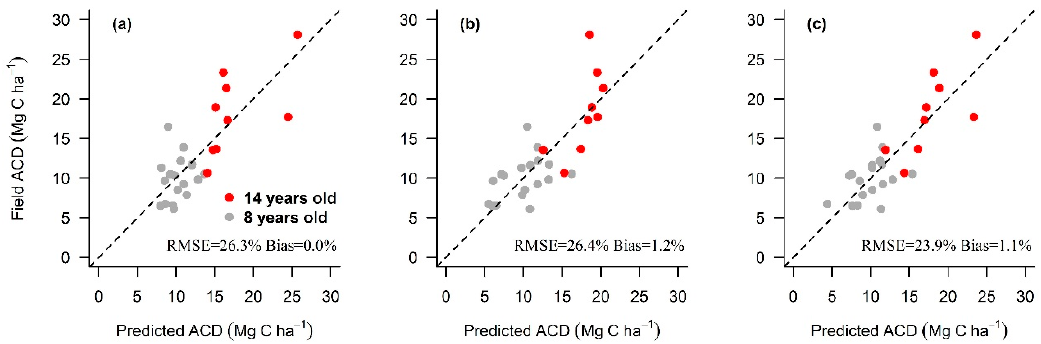
Figure 6. Relationship between aboveground carbon density (ACD) estimated from field data and ( a ) ACD estimated from the leave-one-out cross validated datasets using LiDAR-derived top of canopy height (HTC), ( b ) canopy cover (CC) at 3 m, and ( c ) ACD estimated from TCH and residual CC at 3 m height per plot for 8-year-old and 14-year-old plantations. The 1:1 line is given for reference in both panels (dashed black lines).